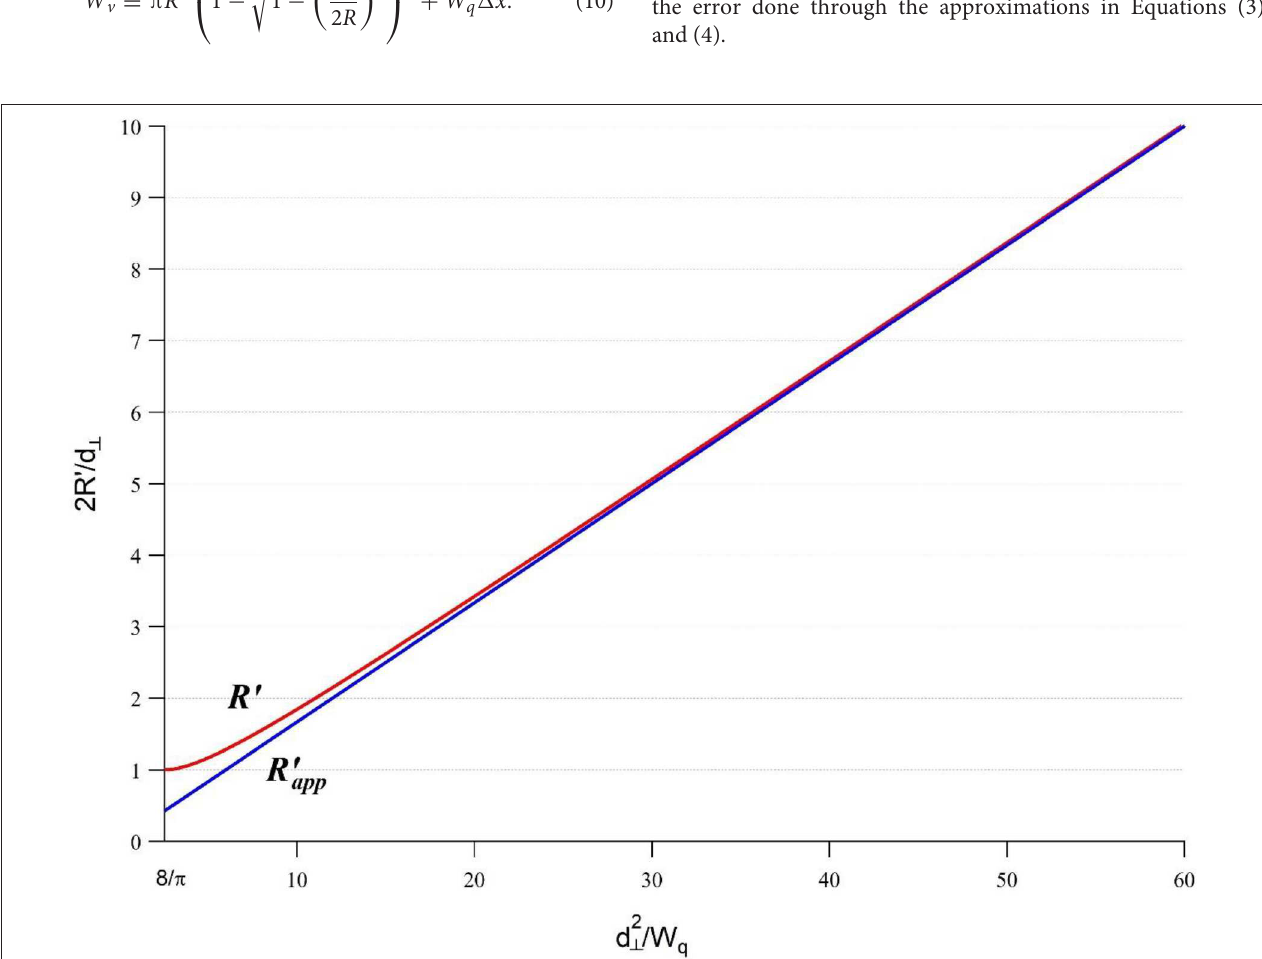
FIGURE 3 | Comparison of the exact numerical solution of Equation (2) (upper curve, red) with the approximated solution (lower curve, blue) of the calculation of R ′ from Equation (6). The diagram shows the ratio of twice the radius R ′ to track width d ⊥ over the ratio of the square of the track width d 2 ⊥ to the planimetric wear W q .